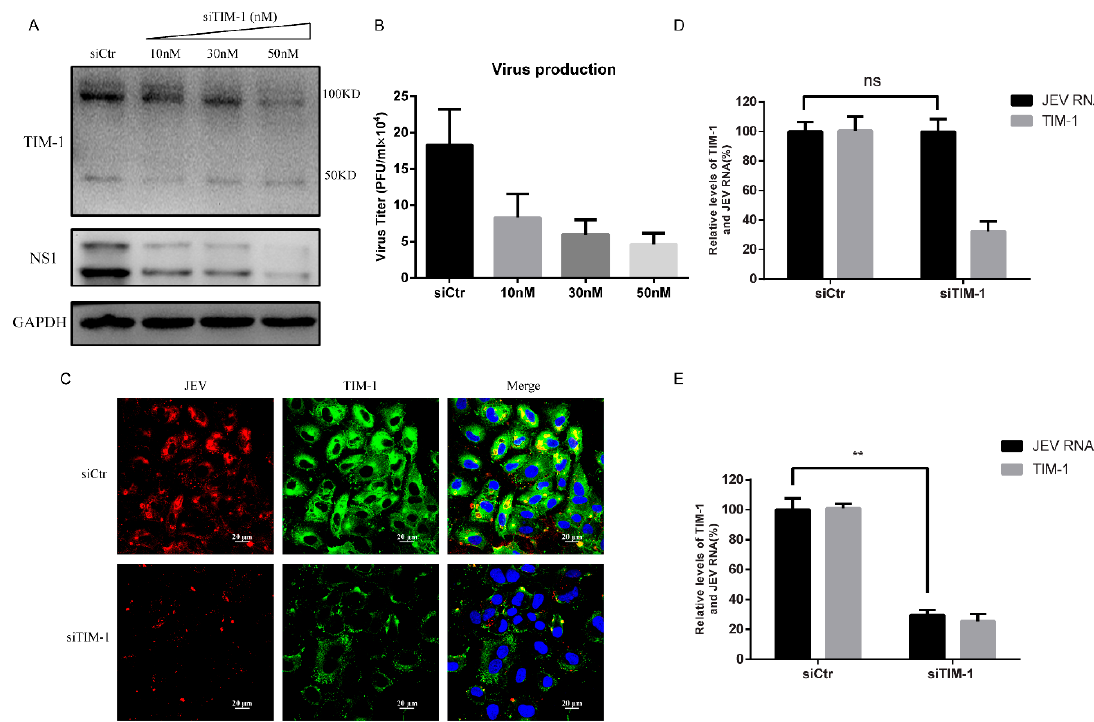
Figure 6. Knockdown of TIM-1 expression impairs JEV entry and infection. A549 cells were seeded in the 12-well plate, and they were transfected with TIM-1-specific siRNA of different concentrations or control siRNA at 50 nM using lipofectamine RNAiMAX Reagent. At 48 h post-transfection, cells were infected with JEV NJ2008 (MOI = 1) for 24 h. ( A ) Cell lysates were harvested to detect the level of JEV NS1 protein and cellular TIM-1 expression by Western blot analysis, using GAPDH as an internal control. One representative experiment out of three is shown; ( B ) production of progeny virions were determined by titering the supernatants of indicated cells in BHK-21 cells. Data are presented as mean ± SD from three independent experiments; ( C ) cells were transfected with TIM-1 siRNA or control siRNA for 48 h before being challenged with JEV NJ2008 (MOI of 10). At 24 h post-infection, cells were fixed and stained for E glycoprotein (red) and TIM-1 (green), followed by confocal microscopy analysis. Scale bars, 20 µ m. A549 cells were transfected with TIM-1 siRNA or control siRNA for 48 h; ( D ) cells were incubated with JEV NJ2008 (MOI of 5) at 4 ◦ C for 30 min and then washed with PBS three times; ( E ) cells were incubated with JEV NJ2008 with a MOI of 5 at 4 ◦ C for 1 h and washed with PBS three times, then shifted to 37 ◦ C for 15 min to allow JEV entry. Cells were treated with proteinase K (1 mg/mL) to remove non-internalized virions. Total RNA was extracted and used for quantification of JEV RNA, the efficiency of TIM-1 silencing and JEV attachment and entry were detected by qRT-PCR. Data are presented as mean ± SD from three independent experiments using t-test. ** p < 0.01.